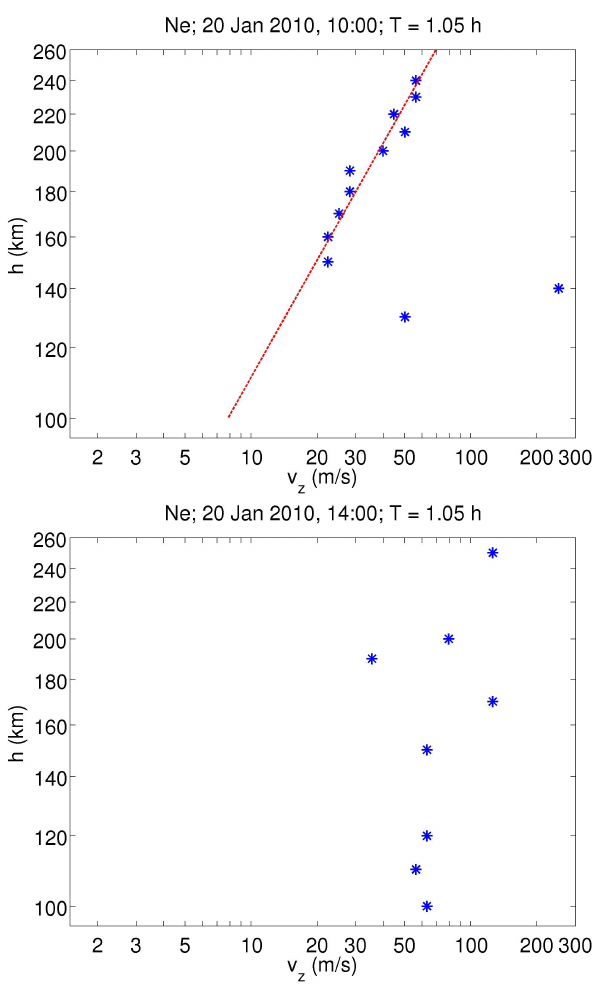
Figure 3. The phase velocities for which a local maximum in cor- relation was found, for the data shown in Fig. 2, at 10:00 and 14:00. At 10:00, a pattern showing an increasing vertical phase velocity with altitude was found, and a curve fitted to it is included in the graph.